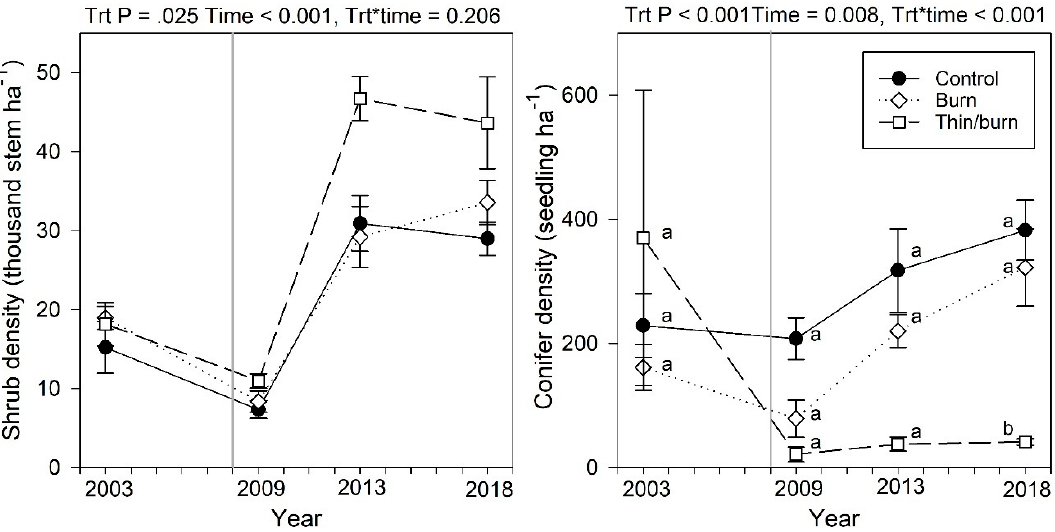
Figure 5. Mean shrub and conifer seedling density ( > 40 cm and ≤ 137 cm in height) plotted through time for both treatments and control. Bars represent 1 standard error of the mean ( n = 4). The vertical line denotes when all treatments were completed (2008). Data comparisons are among treatments and different letters denote a significant treatment effect within a year ( p ≤ 0.05).